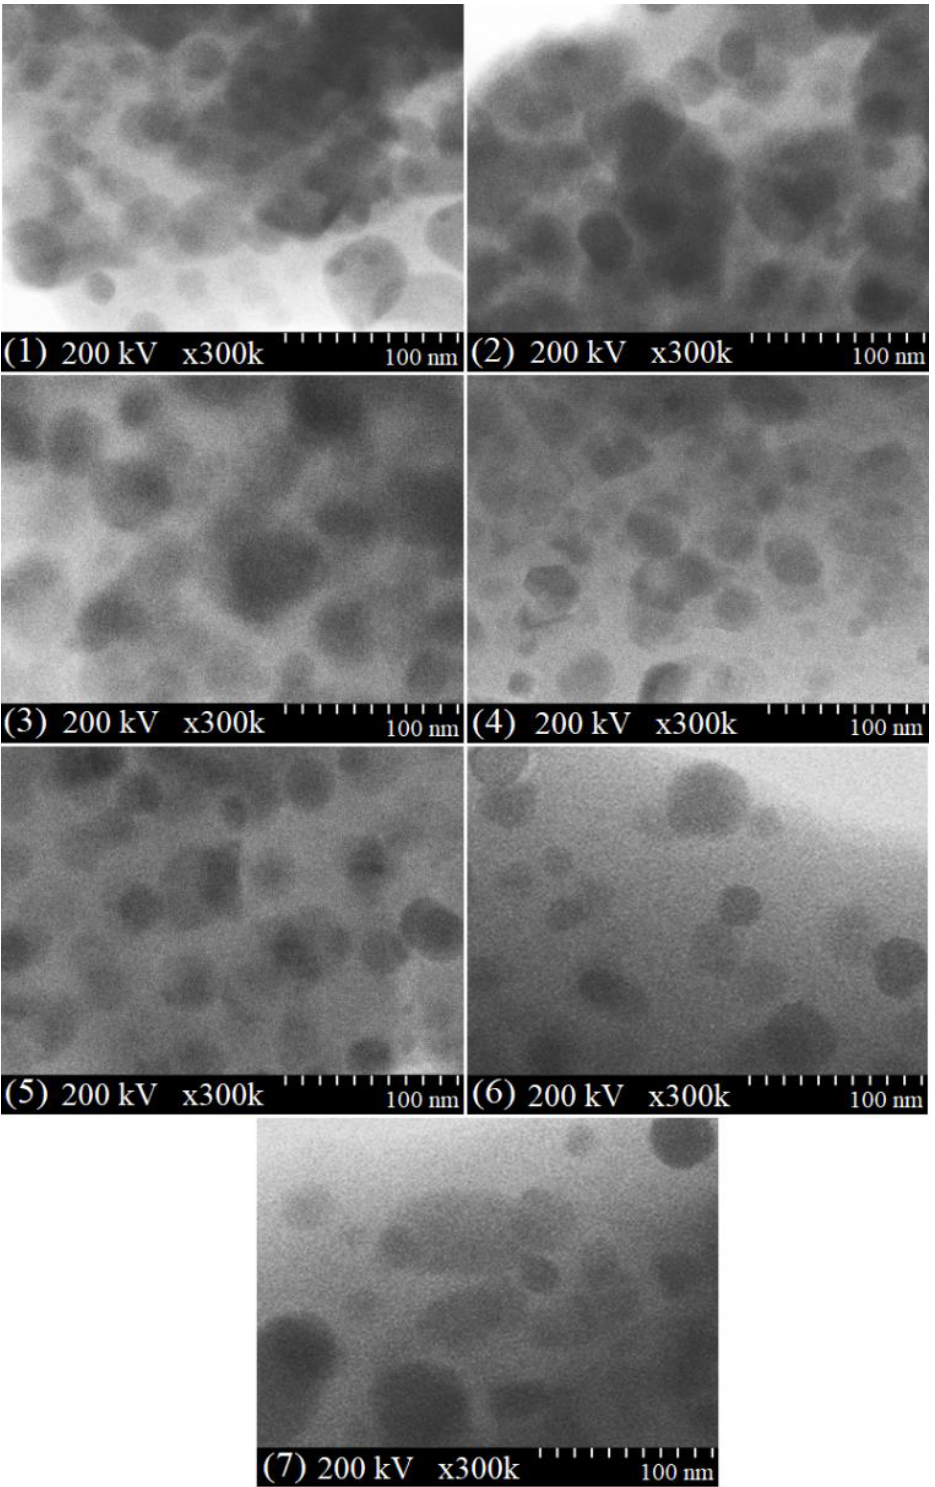
Figure 4. TEM images of Zn 0.6 Co 0.4 Fe 2 O 4 @SiO 2 (1), Ni 0.1 Zn 0.5 Co 0.4 Fe 2 O 4 @SiO 2 (2), Ni 0.2 Zn 0.4 Co 0.4 Fe 2 O 4 @SiO 2 (3), Ni 0.3 Zn 0.3 Co 0.4 Fe 2 O 4 @SiO 2 (4), Ni 0.4 Zn 0.2 Co 0.4 Fe 2 O 4 @SiO 2 (5), Ni 0.5 Zn 0.1 Co 0.4 Fe 2 O